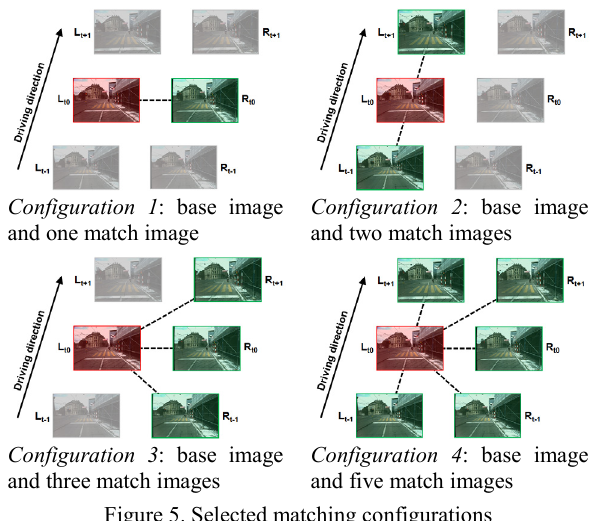
Figure 5. Selected matching configurations